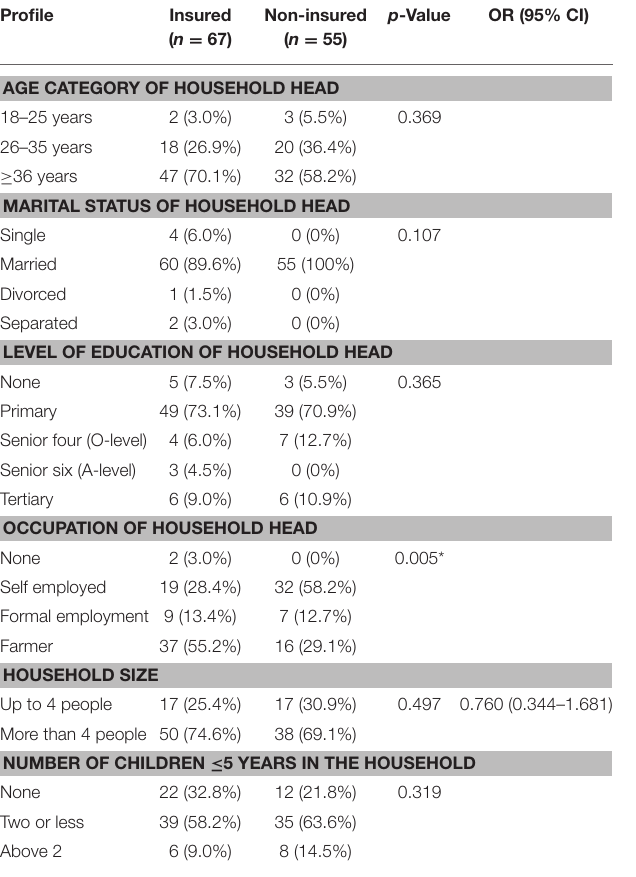
TABLE 6 | Characteristics of households that took a sick child to BCH in the past 6